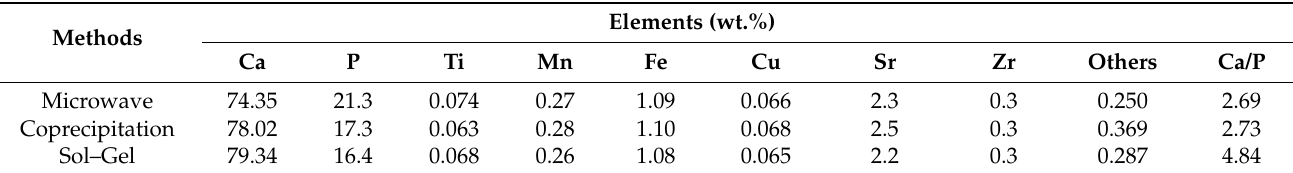
Table 1. Elemental analysis of HAp synthesized by microwave, coprecipitation, and sol–gel. Methods